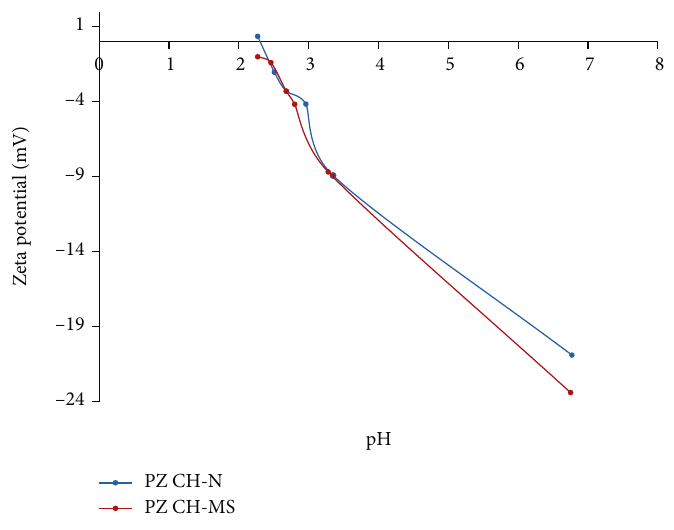
Figure 6: Zeta potential versus pH for CH-N and CH-MS